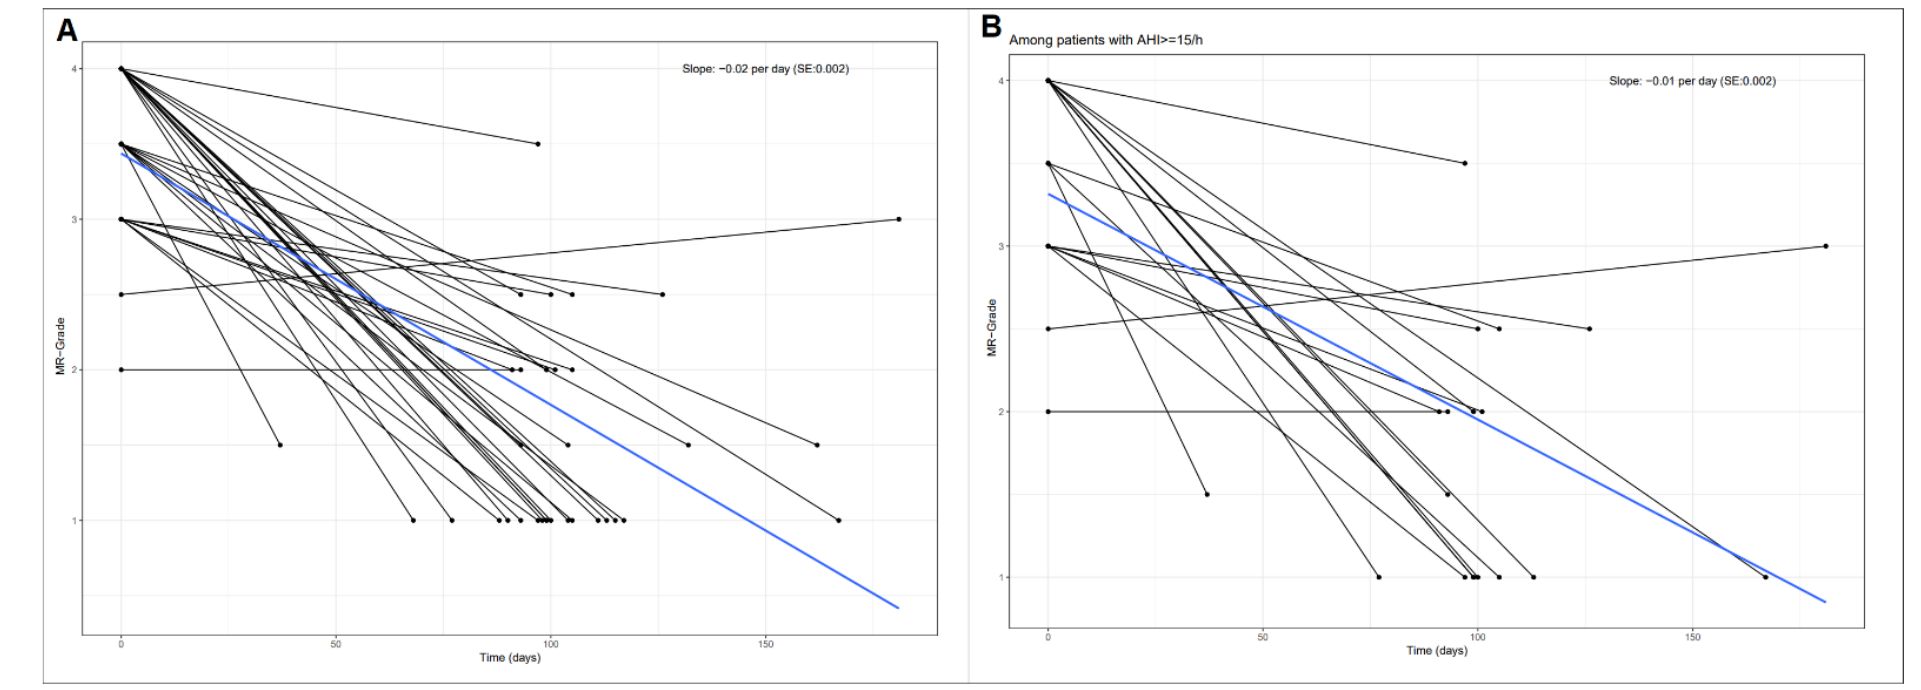
Figure 2. Progression of mitral valve regurgitation grade during follow-up in 34 patients. ( A ) In all patients ( p < 0.001). ( B ) In patients with baseline-AHI ≥ 15 ( p < 0.001).